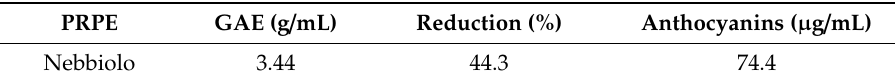
Table 1. Phenolic content (gallic acid equivalent (GAE) mg / mL), antioxidant power (reduction (%) of DPPH radical) and anthocyanin content of Nebbiolo